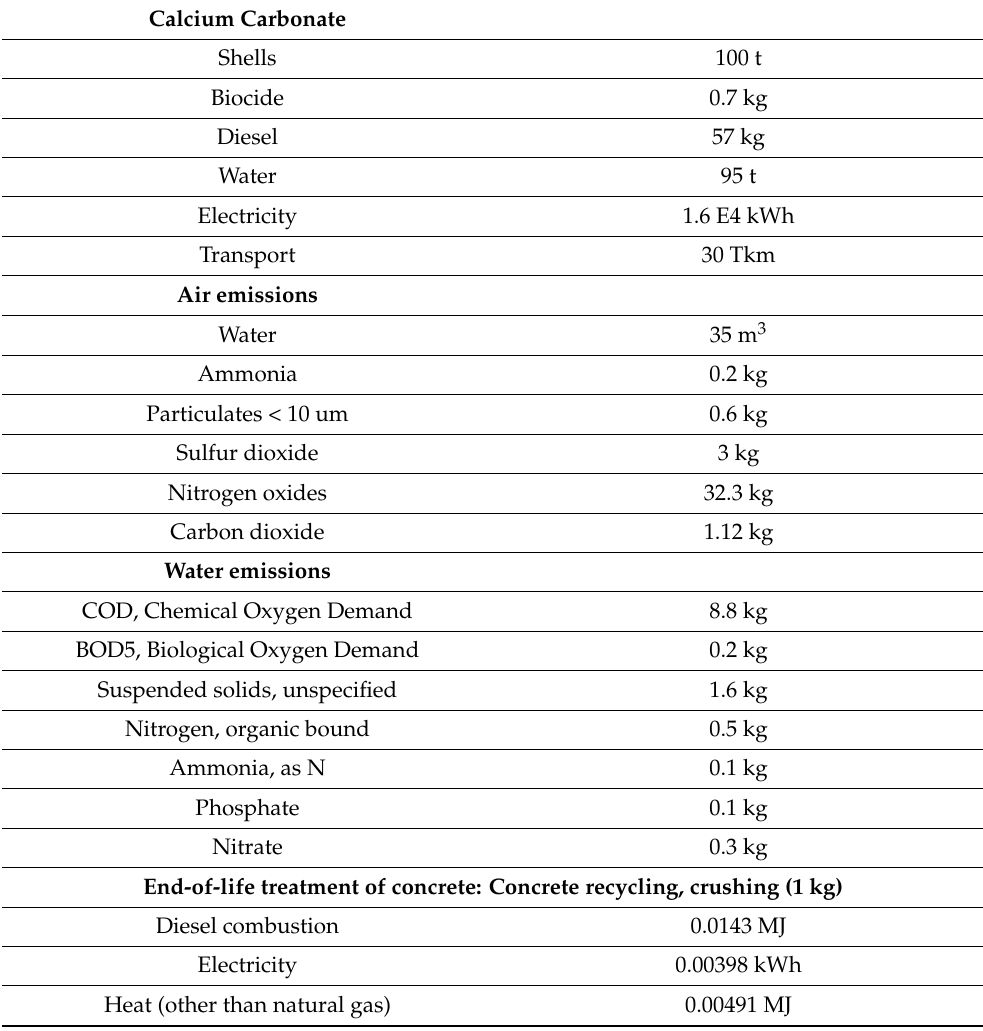
Table 5. Inventory: Production of calcium carbonate from shells [20].